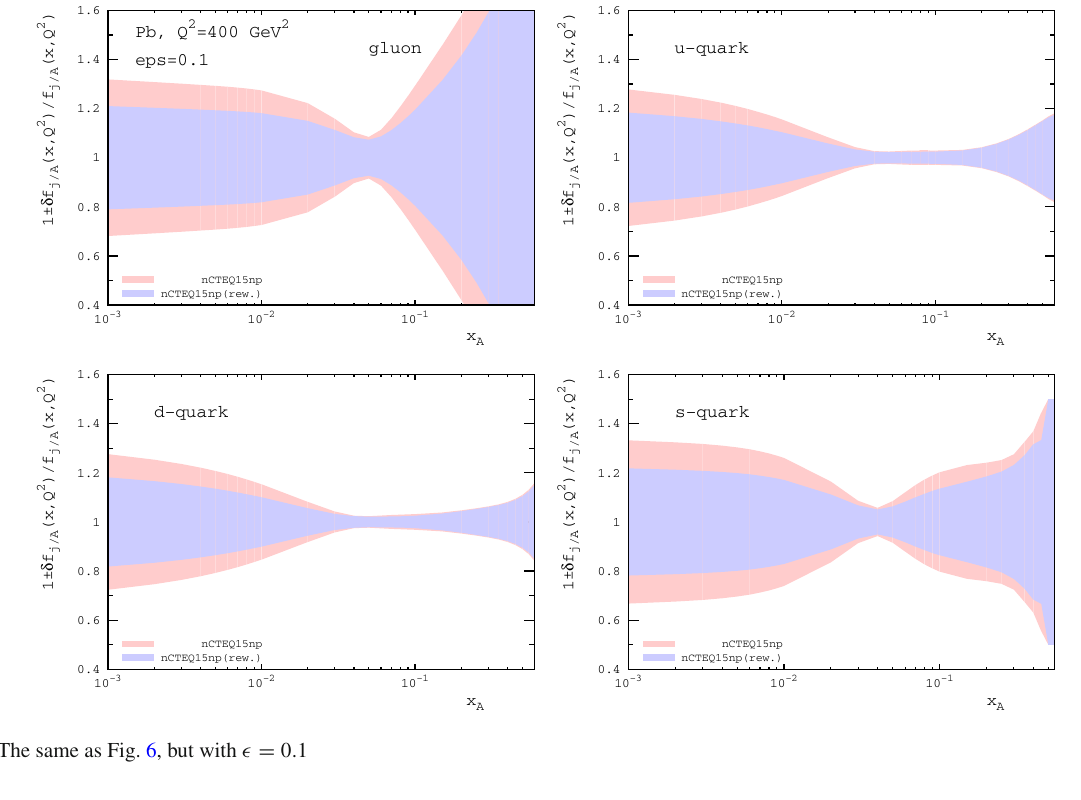
Fig. 7 The same as Fig. 6, but with (cid:6) = 0 . 1